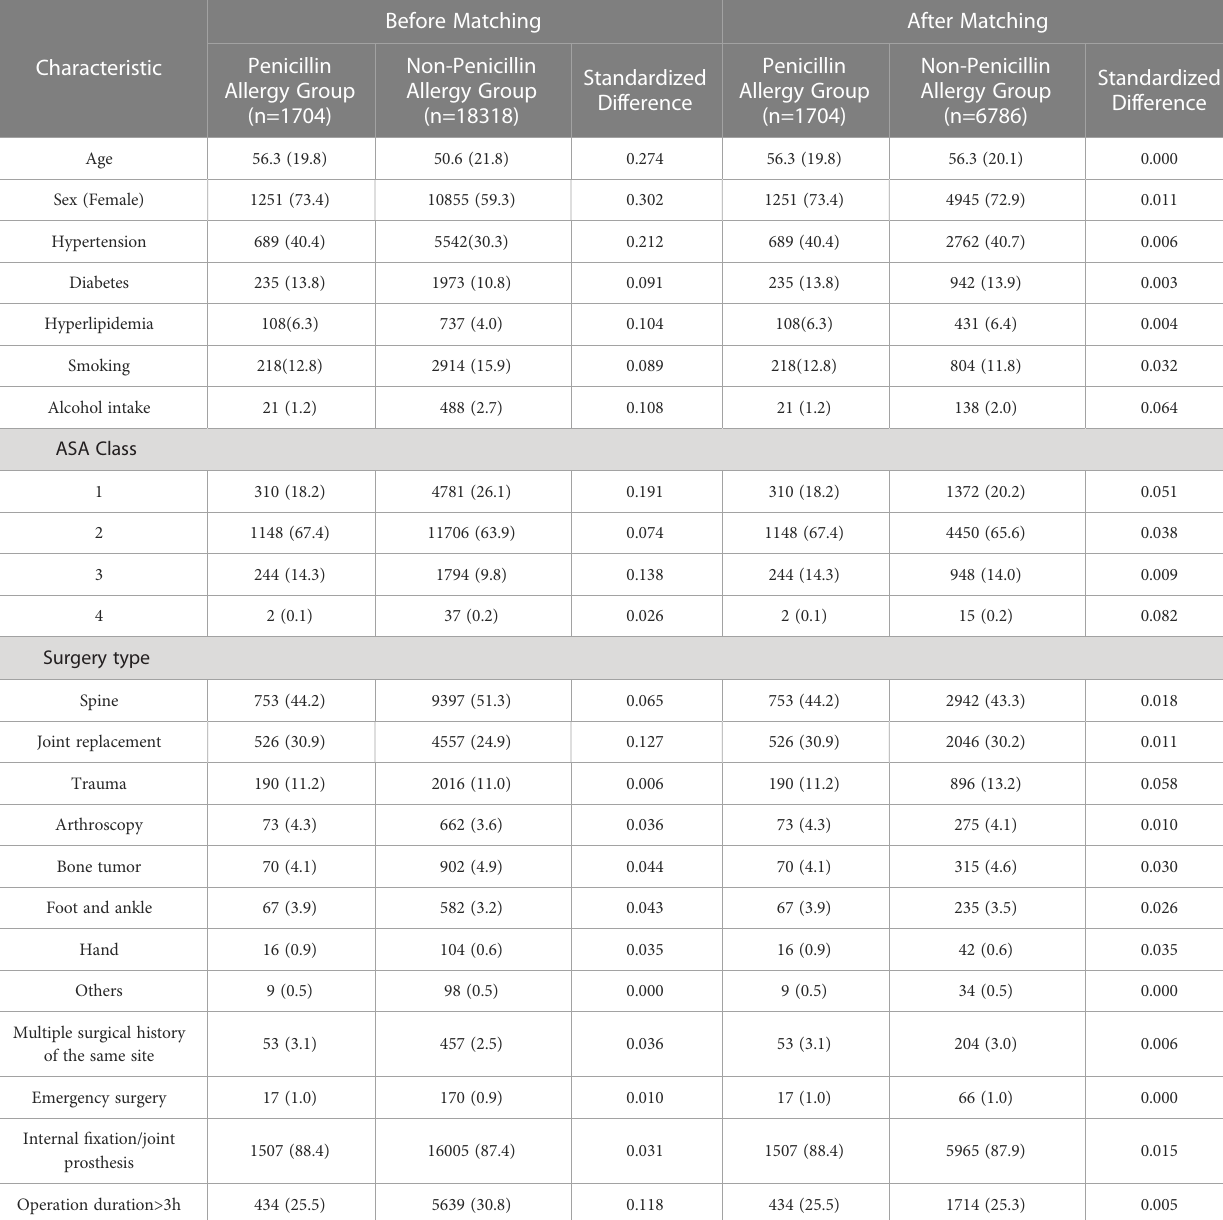
TABLE 1 Baseline Characteristics before and after propensity score matching.